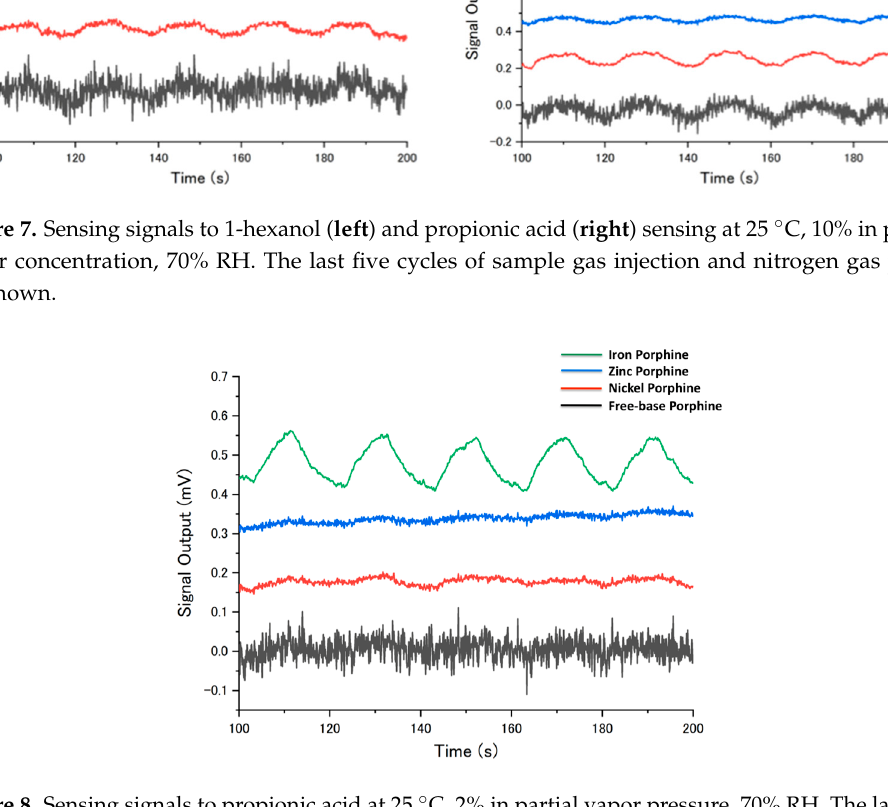
Figure 8. Sensing signals to propionic acid at 25 °C, 2% in partial vapor pressure, 70% RH. The last five cycles of sample gas injection and nitrogen gas purge are shown.